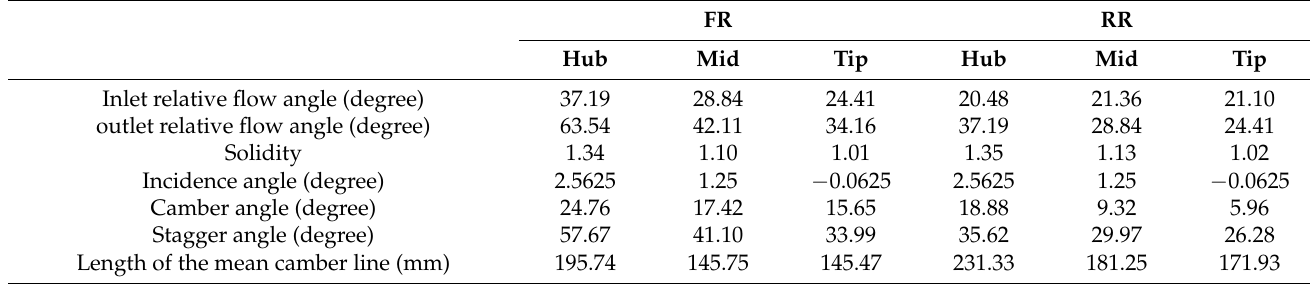
Table 7. Profile data of blades of CRF